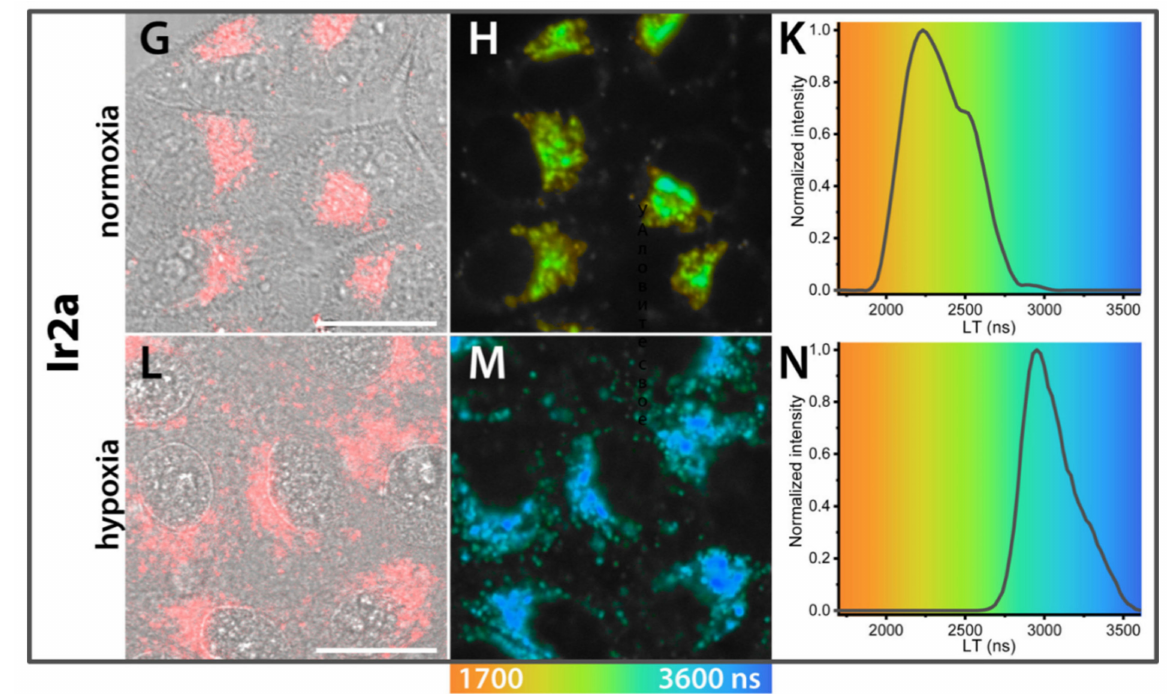
Figure 8. Phosphorescence lifetime distribution in HeLa cells incubated with 75 µ M of Ir2 ( A – F ) and Ir2a ( G – N ) for 24 h under normoxia (A–C, G–K) and hypoxia conditions (D–F, L–N). A, D, G, L—luminescent microscopy (excitation 405 nm, detection 663–738 nm) stacked with DIC (differential interference contrast) image. B, E, H, M—PLIM images (excitation 405 nm, detection 690–750 nm), colors corresponds to the lifetime in the range 1700–3600 ns. C, F, K, N—lifetime distribution for whole PLIM